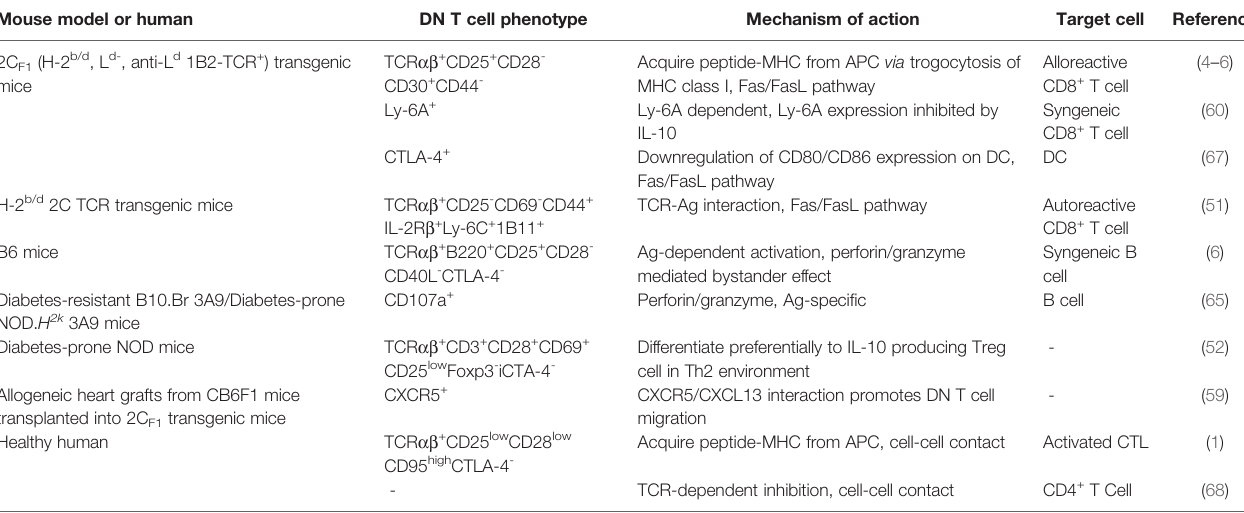
TABLE 1 | Regulatory DN T cell in immune